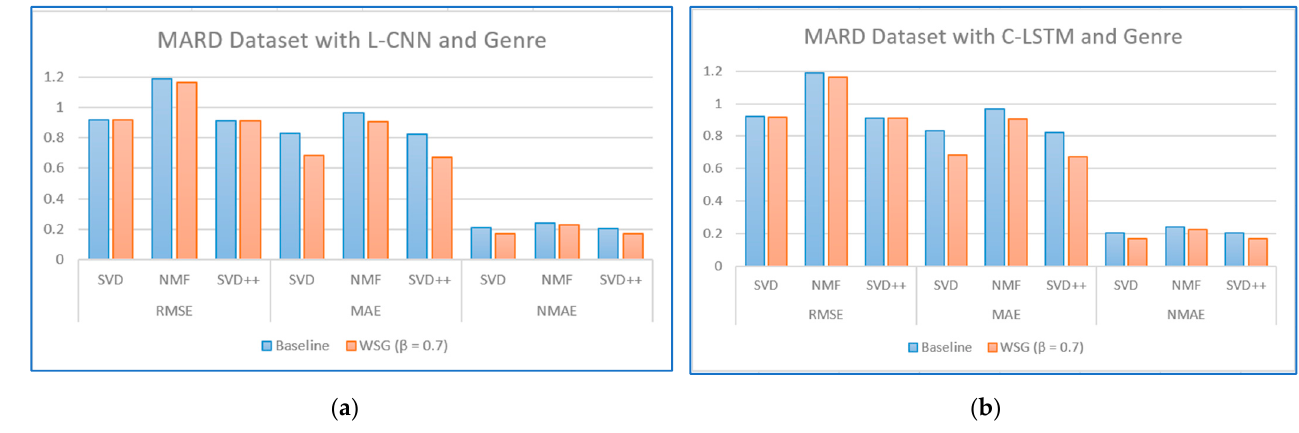
Figure 11. RMSE, MAE, and NMAE with and without C-LSTM sentiment and genres-based model and different values of β on Amazon Movie dataset.